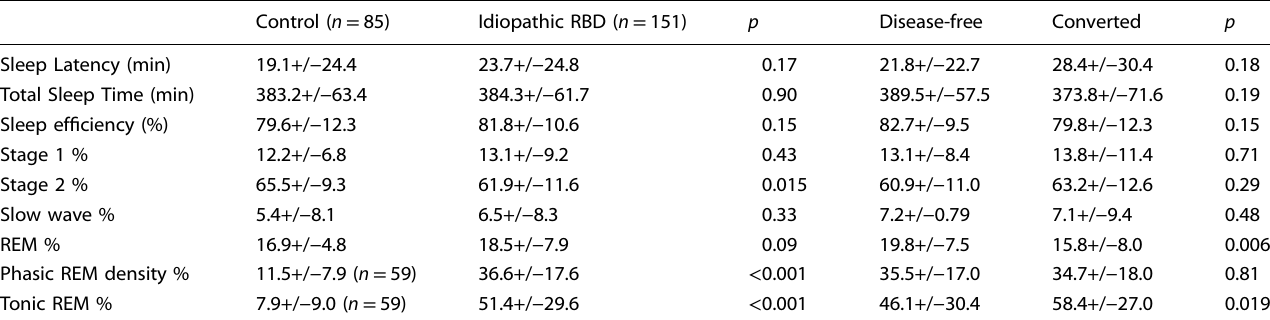
Table 3. Polysomnographic